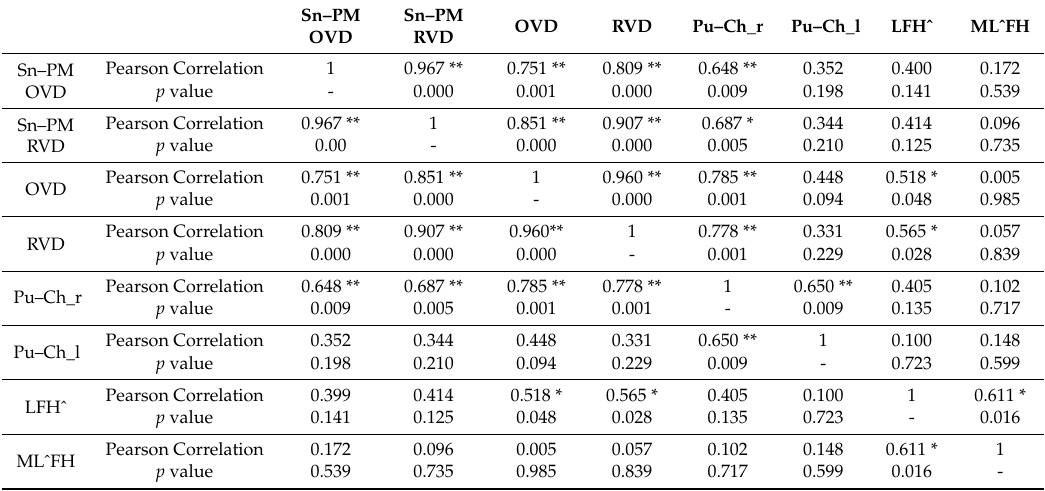
Table 3. Correlation between clinical anthropometric and cephalometric measurements.